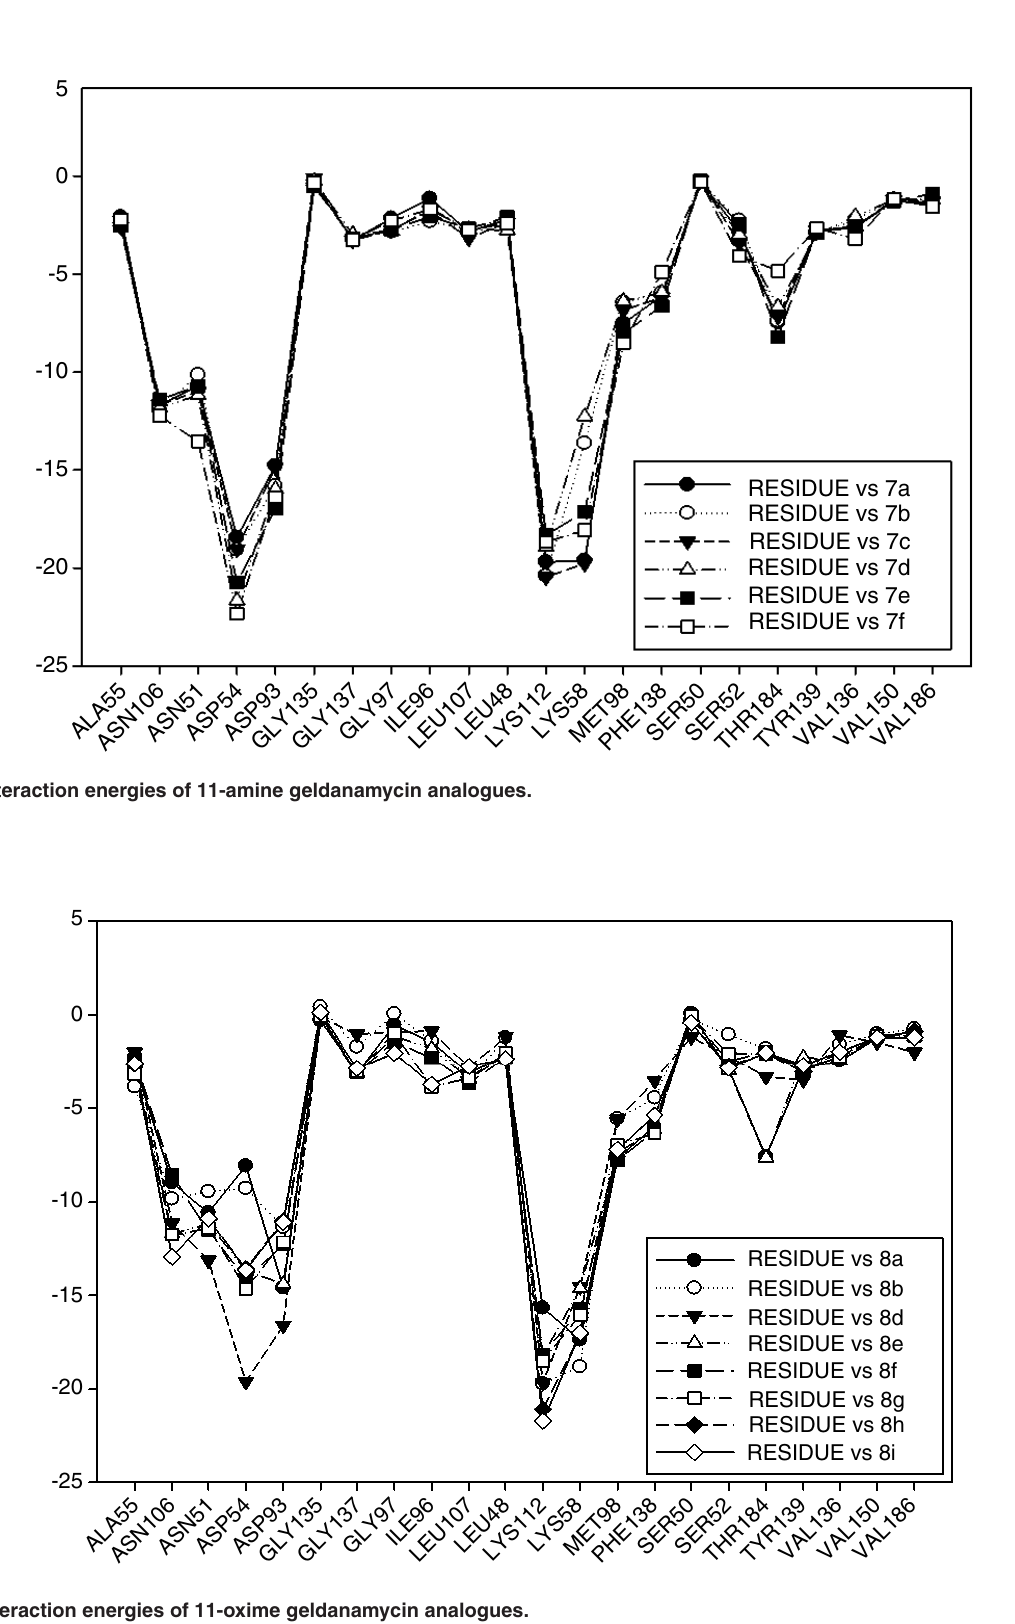
Figure 15. Interaction energies of 11-oxime geldanamycin